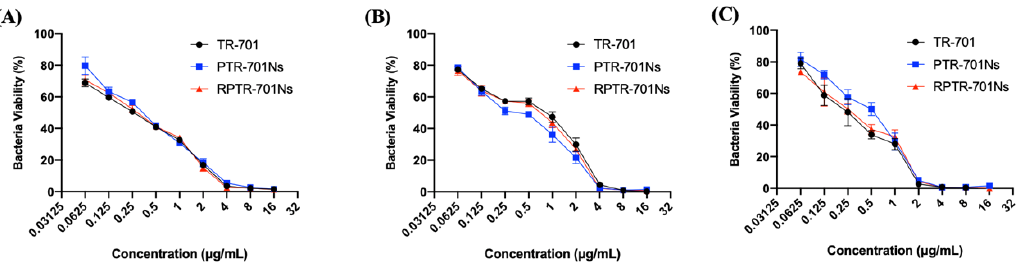
Figure 8. In vitro anti-bacteria efficacy of nanoparticles against, ( A ) MRSA USA 300, ( B ) MRSA ATCC 43300 and ( C ) MSSA NTCT 8325. Bacteria were administrated with TR-701, PTR-701Ns and RPTR-701Ns at different TR-701 concentrations. Data were presented as mean ± SD ( n = 6).